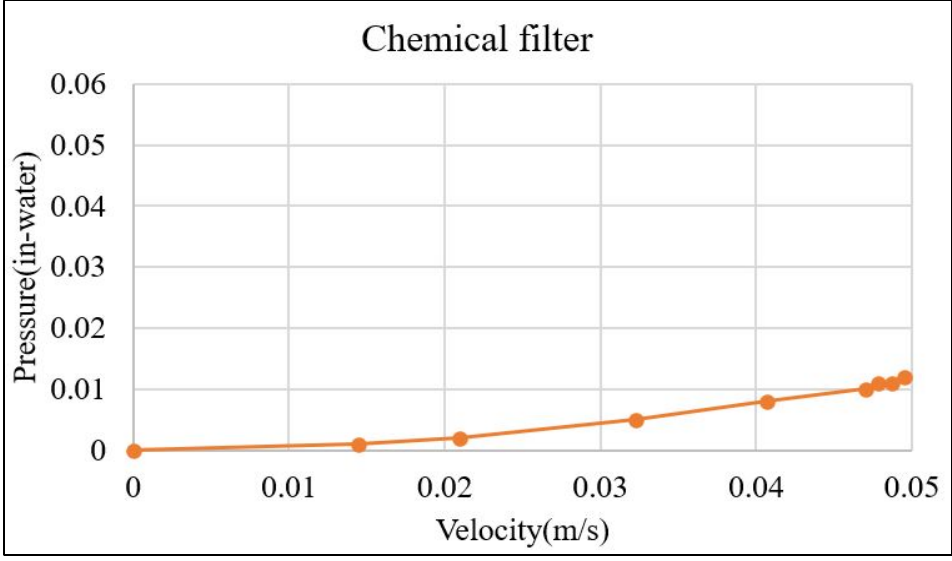
Figure 18. P-Q curve of the primary filter screen. Table 3. Technical principles for air purifier filter screens [24]. Filter Screen Name